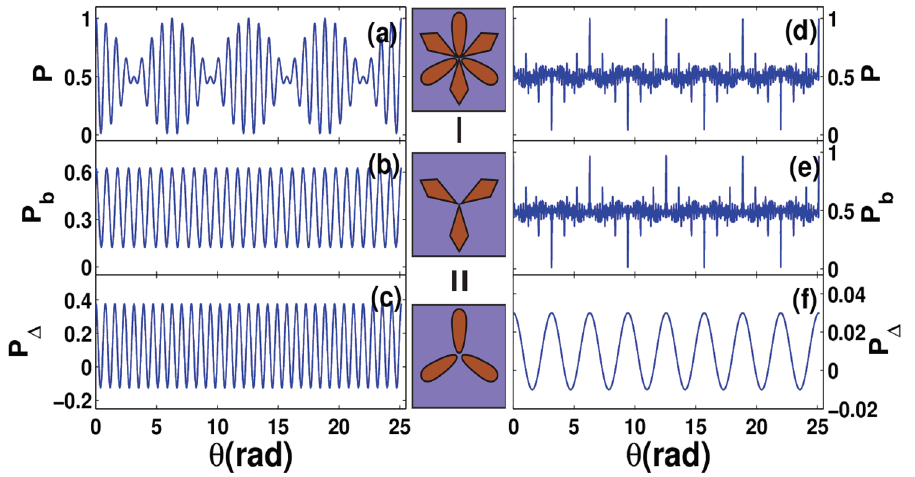
Figure 4. Theoretical results for defect recognition. The center column shows the progress of defect recognition sketch. The top pattern shows the incident multimode NOON states. The middle one is the output pattern when the defect is introduced. The bottom one shows the difference between the above two. The left column displays results for the situation of equal weighted superposition by l included, and it is the same as Fig. 1(a). ( b ) Is the result when the mode l between ( a ) and ( b ). The right column shows results for the situation of the mode composed of all prime number modes between 1 and 100 with the equal weight. ( d ) Is the result when all prime modes are included, and it is the same as Fig. 1(d). ( e ) Is the result when the mode l and ( c ).